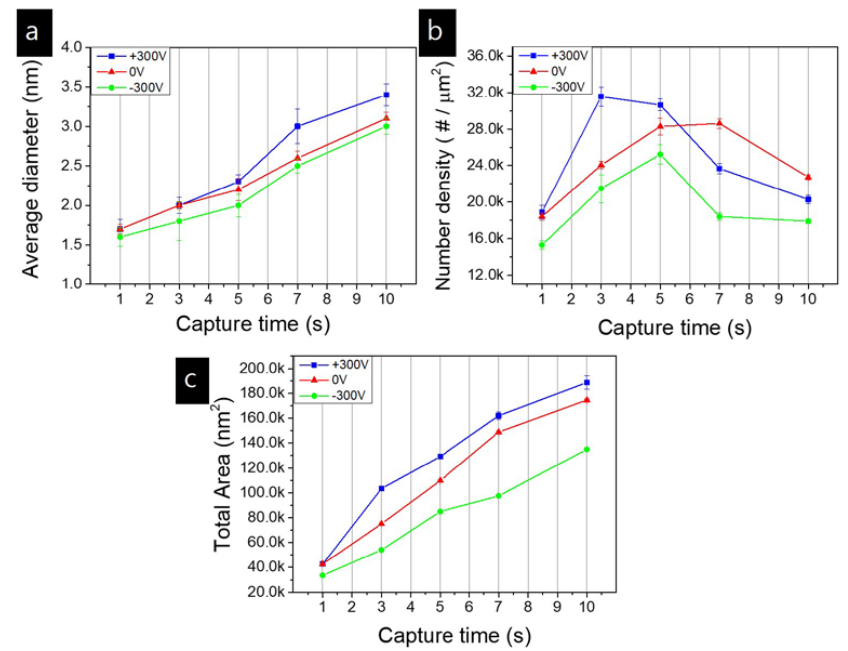
Figure 6. Plots of ( a ) particle average diameter; ( b ) particle count per μm 2 ; and ( c ) total area of Ag particle per μm 2 against the capture time analyzed by the ImageJ program.